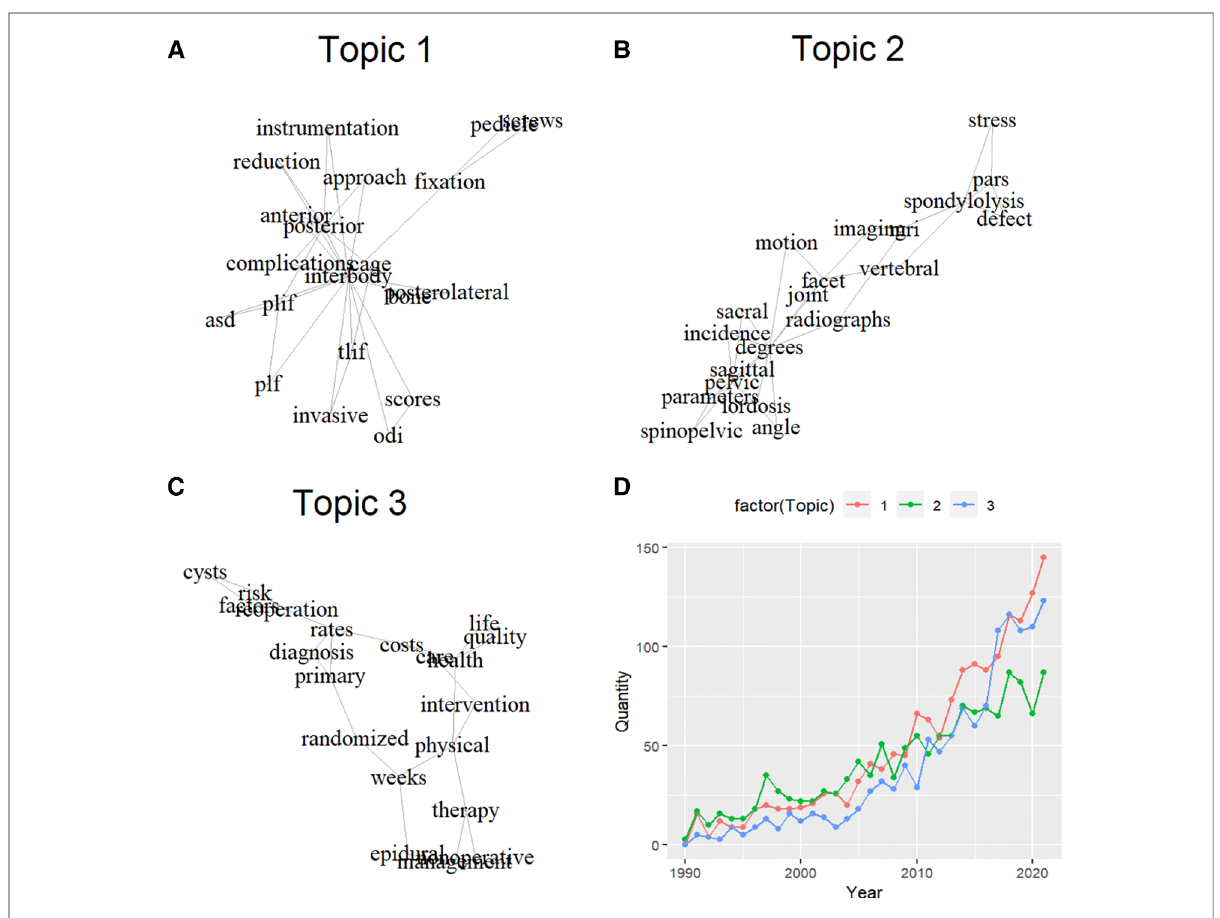
FIGURE 3 Research topics of lumbar spondylolisthesis over the past 3 decades. ( A ) topic 1- surgery; ( B ) topic 2- radiology; ( C ) Topic 3-epidemiology; ( D ) publication productivity of the three topics over the past three